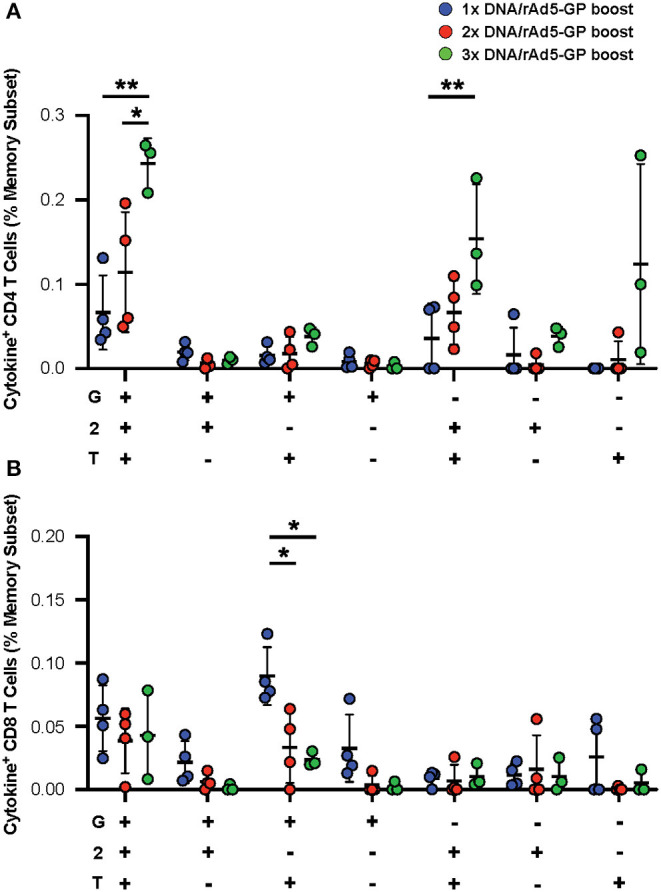
GP specific polyfunctional T-cell. PBMCs were stimulated with EBOV GP peptides. The functionality of antigen-specific CD4+
(A) and CD8+
(B) T-cell responses were assessed in DNA prime rAd5 boost NHP's by analyzing the individual cytokine (G:IFNγ, T:TNFa, and 2:IL-2) response pattern. Statistical analysis between more than two groups was performed using a one-way ANOVA with Tukey's post hoc test; *p < 0.05, **p < 0.01; mean ± standard deviation shown.